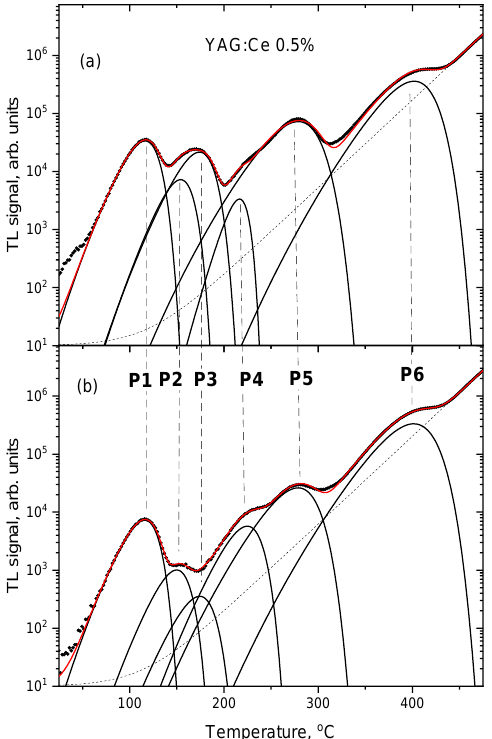
Figure 10. TL glow-curves of YAG:Ce 0.5% crystal, deconvoluted into single peaks. ( a ) no IR illumination, ( b ) after 2000 s of IR illumination. Dose 2 Gy.